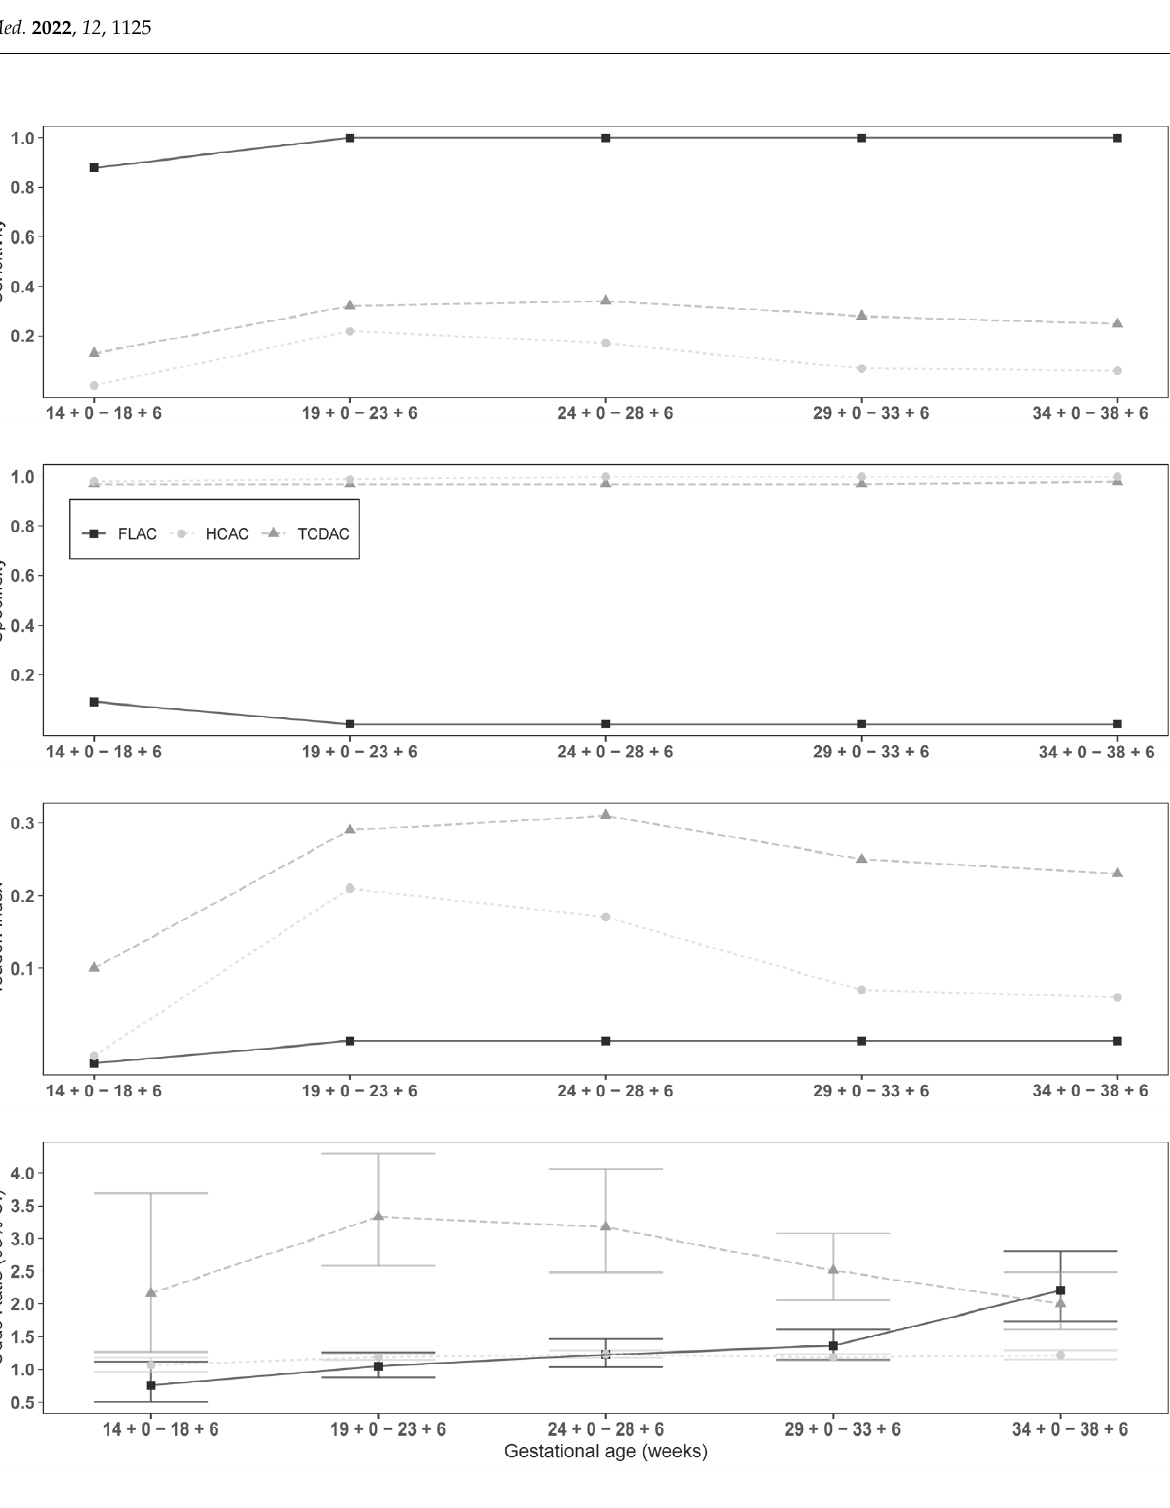
Figure 3. ( A ) Results of ultrasound variable cutoff values for detection of FGR. Results of gestational- age-dependent cutoff values are presented in Supplementary Table S6. AC = abdominal circumference, BPD = biparietal diameter, FL = femur length, HC = head circumference, TCD = transcerebellar diameter. ( B ) Results of ultrasound ratio cutoff values for detection of FGR. Results of gestational-age- dependent cutoff values are presented in Supplementary Table S6. FL/AC = femur length/abdominal circumference, HC/AC = head circumference/abdominal circumference, TCD/AC = transcerebellar circumference/abdominal